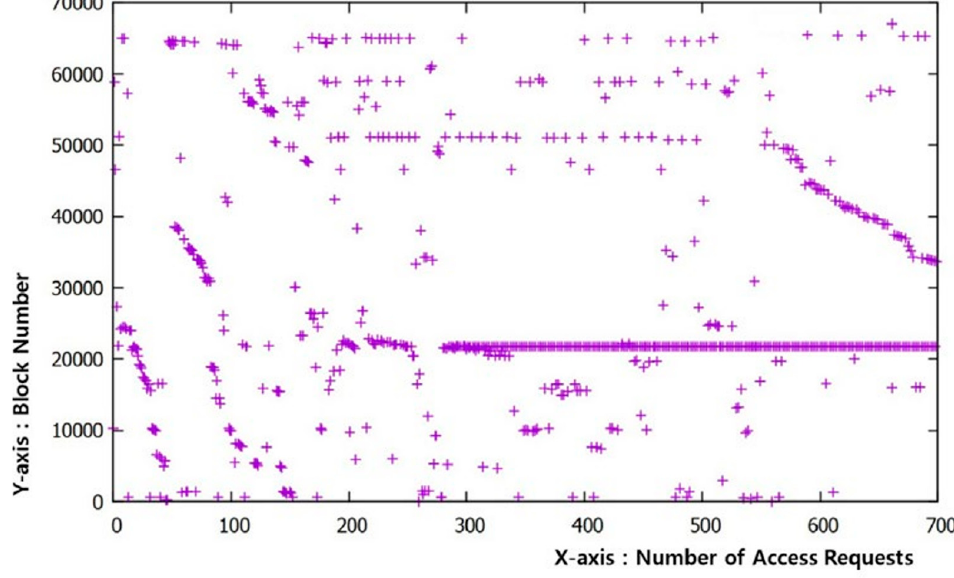
Figure 6. Memory access patterns of graph processing.